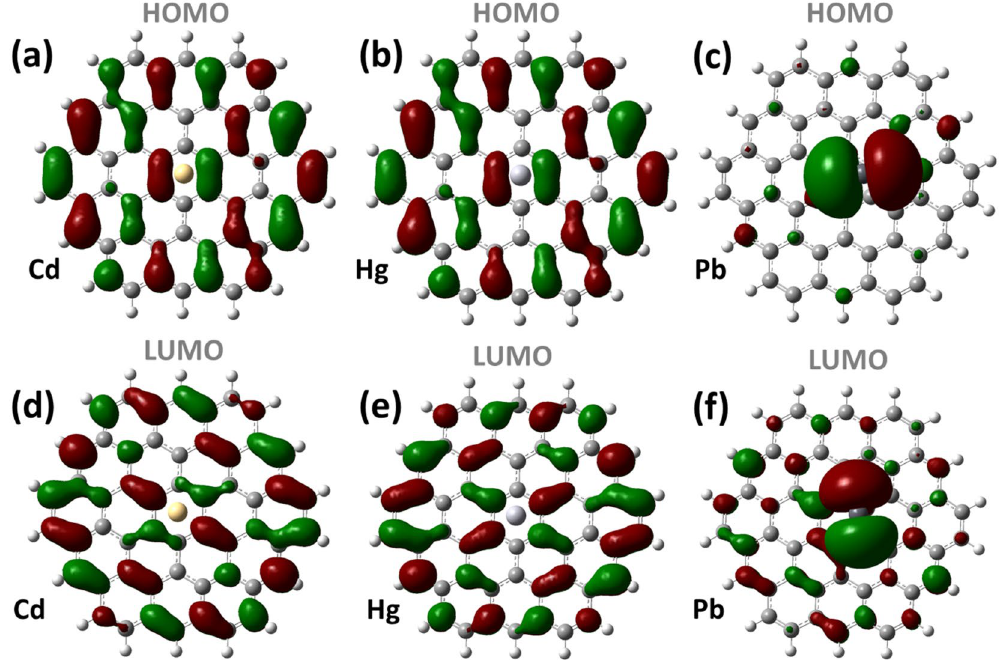
Figure 4. Molecular orbitals for C 54 H 18 GQDs interacted with heavy metals: HOMO ( a ) and LUMO ( d ) of Cd@ C 54 H 18 ; HOMO ( b ) and LUMO ( e ) of Hg@C 54 H 18 ; and HOMO ( c ) and LUMO (f) of Pb@C 54 H 18